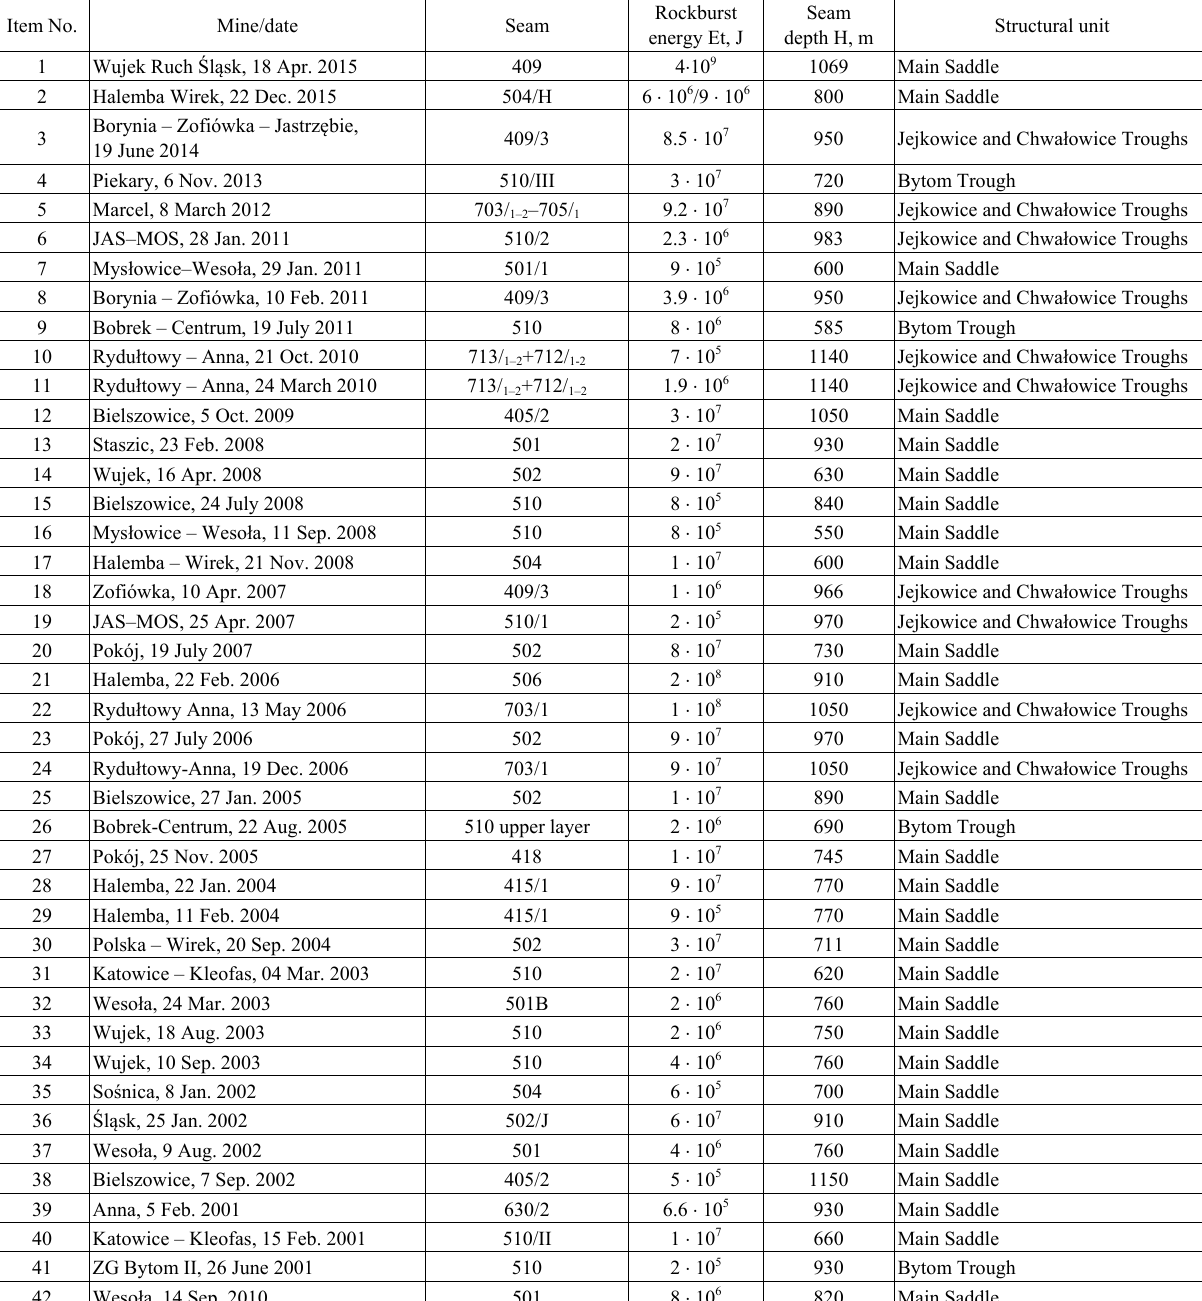
Table 2. List of parameters of tremors occurred between 2001 and 2015 in USCB Item